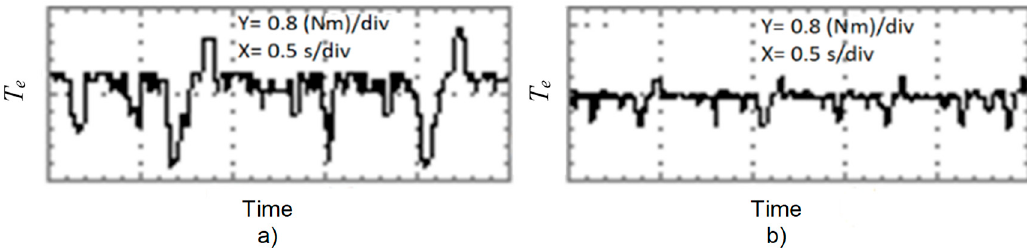
Figure 10. The torque response of the 6PIM in steady state with 4 𝑁𝑚 load, derived by ( a ) duty cycle control strategy; ( b ) proposed method.